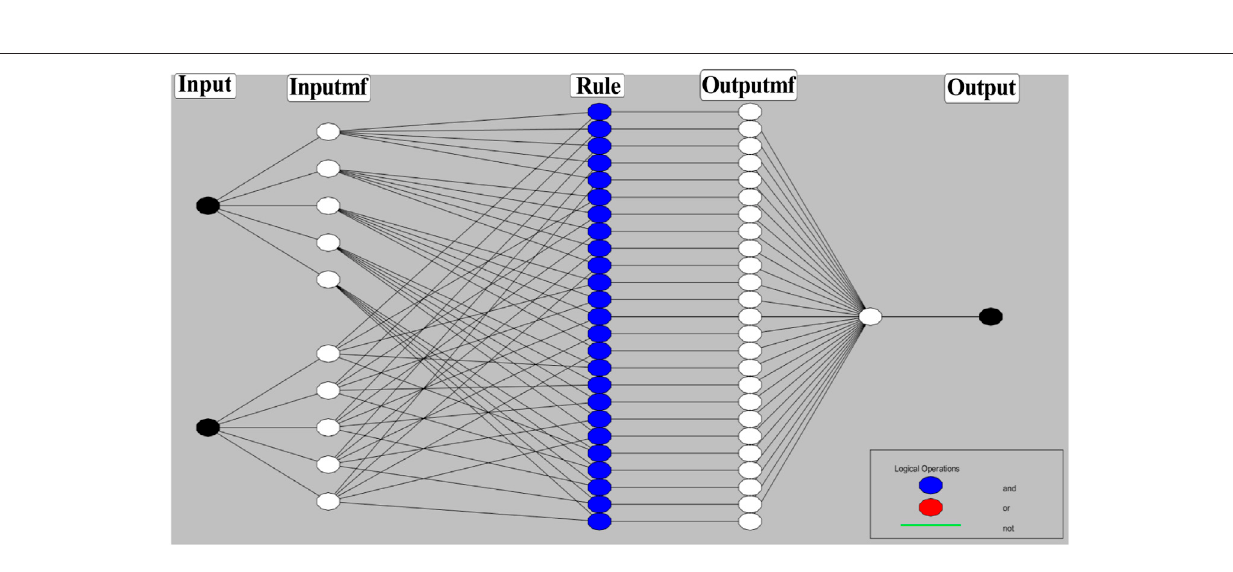
( Supplementary Table S2 ). The feasible consolidation of F − and H + generates 38 rules ( Supplementary Table S1 and Supplementary Figure S2 ). Furthermore, the variation of emission intensity upon combined actions of H + and F − is portrayed in a 3D plot ( Figure 6 ).